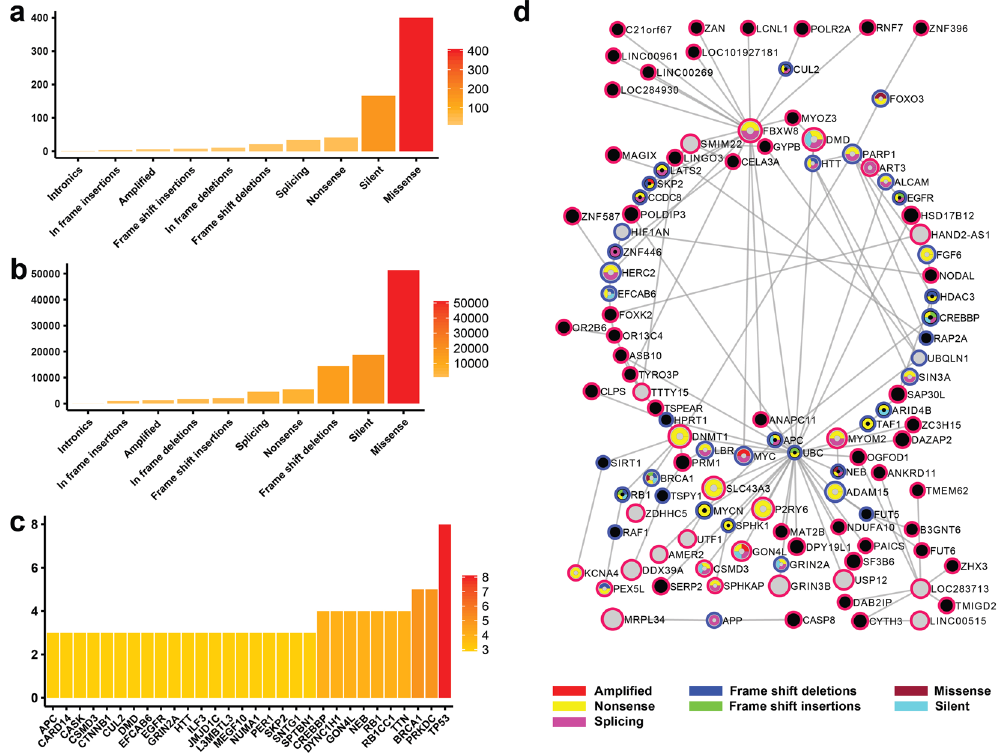
Figure 4. Reconstructed genetic landscape of ovarian cancer PIE-MIN. ( a ) Frequency of a given mutation type mapped to ovarian cancer PIE-MIN. ( b ) Cumulative number of protein interacting partners by mutation type in ovarian cancer PIE-MIN. ( c ) Frequency of mapped genes showing at least three different mutation types mapped to ovarian cancer PIE-MIN. ( d ) Presence of cancer-related Class I and Class II genes. Ovarian cancer PIE-MIN enriched with mutated genes from a genome-wide study implying the importance of Class I oncogenes in cancer network. Genes with detected mutations indicated by node color codes corresponding to types of mutations they display. Genes identified from protein-protein interactions within a MIN indicated by blue borders. Grey nodes with red borders indicate differentially expressed genes, which are also Class I cancer genes; black nodes indicate not differentially expressed genes; black nodes with red borders denote Class II cancer gene